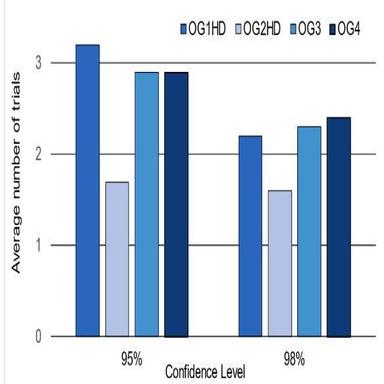
Average number of trials across 10 randomised permutations to reach 95 % and 98 % confidence intervals.